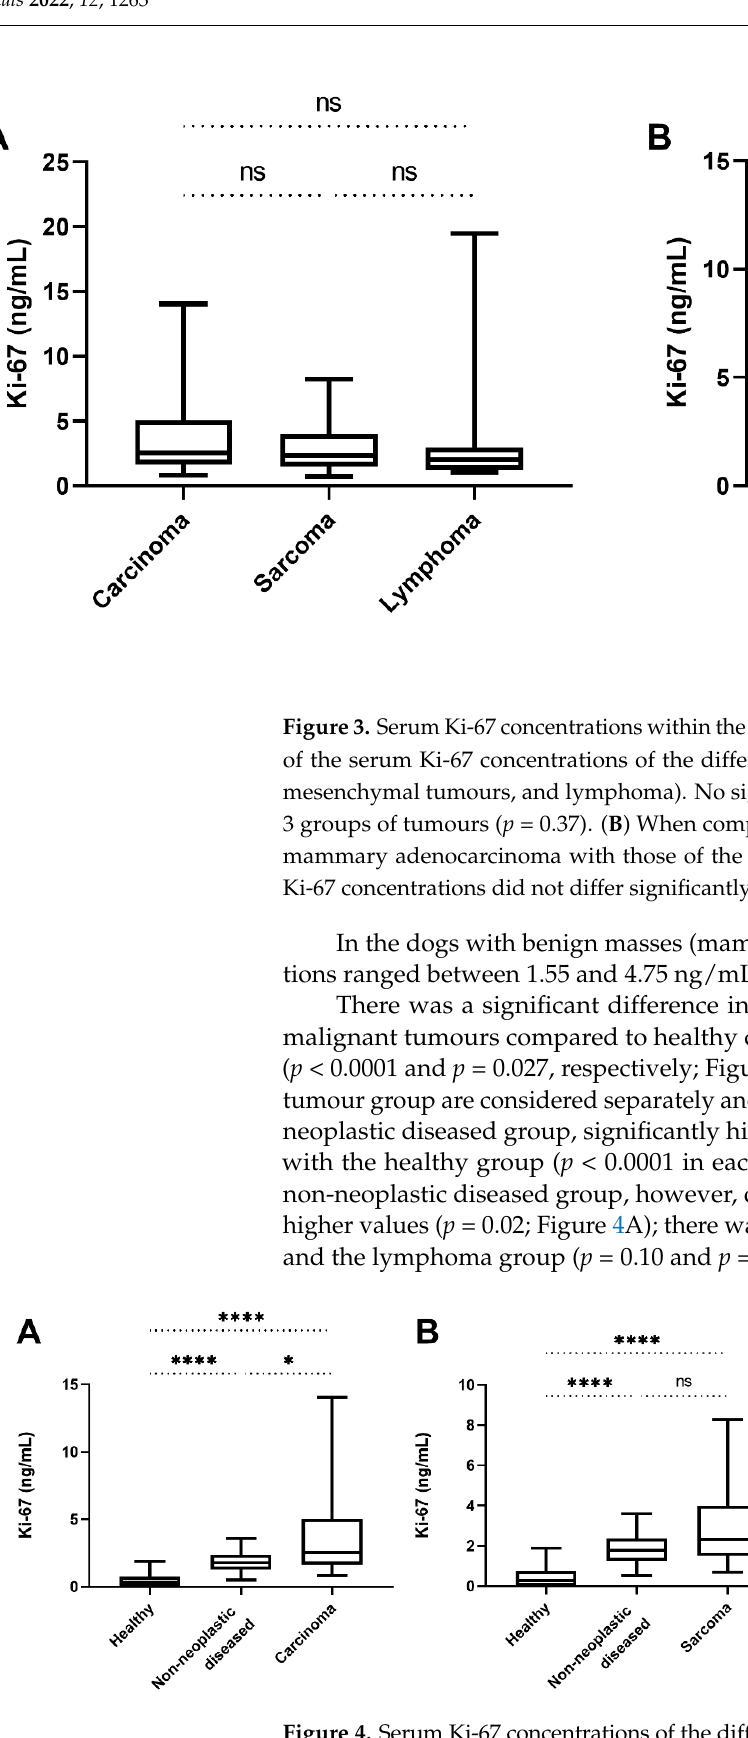
Figure 4. Serum Ki-67 concentrations of the different malignant tumour groups were also compared individually with the healthy group, and the non-neoplastic diseased group. ( A ) The Ki-67 concen- trations of the carcinoma group differed significantly compared to the healthy control group ( p < 0.0001) and compared to the group of dogs with non-neoplastic diseases ( p = 0.0198). ( B ) A compar- ison of the Ki-67 concentrations of the sarcoma group revealed significantly higher concentrations than the ones in the healthy control group ( p < 0.0001), whereas concentrations in the group with non-neoplastic diseases did not differ significantly compared to the sarcoma group ( p = 0.102). (C) The Ki-67 concentrations of the lymphoma group were significantly higher than the ones of the healthy dogs ( p < 0.0001), however, compared to the group with non-neoplastic diseases, there was no significant difference ( p = 0.439). (ns) not significant; (*) p < 0.05; (****) p < 0.0001. The calculated tumour volumes of the tumours in the carcinoma group and in the sarcoma group are presented in Table 3. Tumour volume of neither carcinomas nor sar- comas showed a noticeable influence on serum Ki-67 concentrations when tested by linear regression ( p = 0.28 and p = 0.955, respectively; Figure 5A,B). Table 3. Tumour volume. Groups